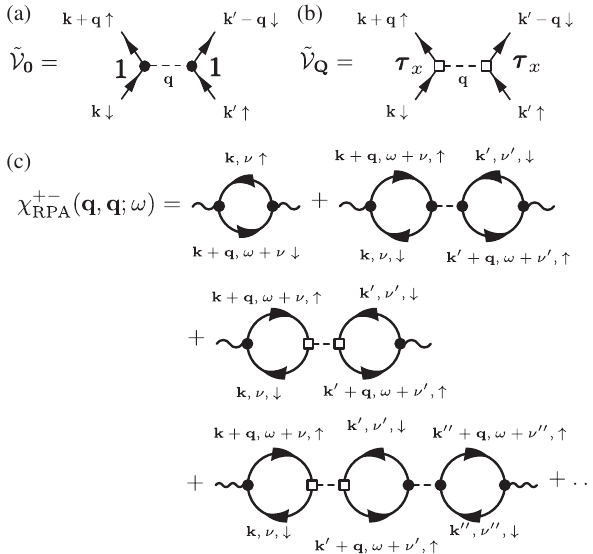
FIG. 29. Diagrammatic representation of the alternative form of the interaction vertices suited to computing the transverse spin susceptibility for (a) Eq. (A11) and (b) Eq. (A12). In (c), we show the RPA series for the transverse spin susceptibility. The sums over internal momenta k , k 0 , k 00 and frequencies ν , ν 0 , ν 00 have not been written